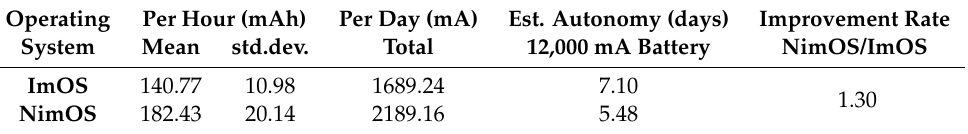
Table 7. Long-term energy consumption